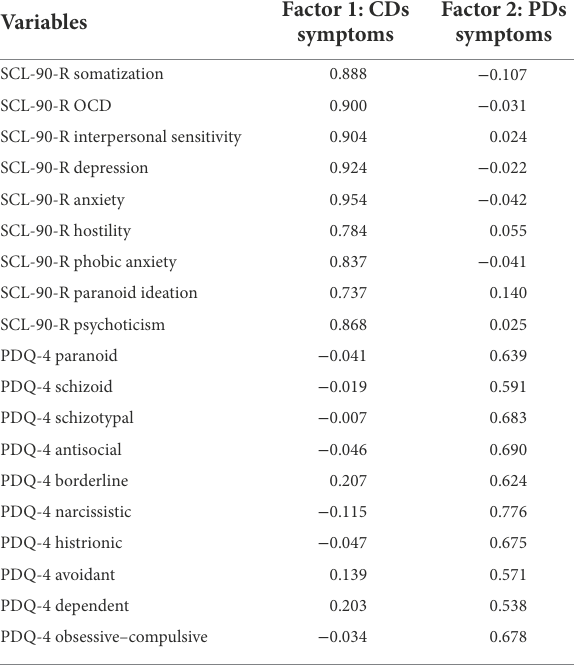
TABLE 2 The pattern coefficients from a conjoint exploratory factor analysis of SCL-90 and PDQ-4 symptom